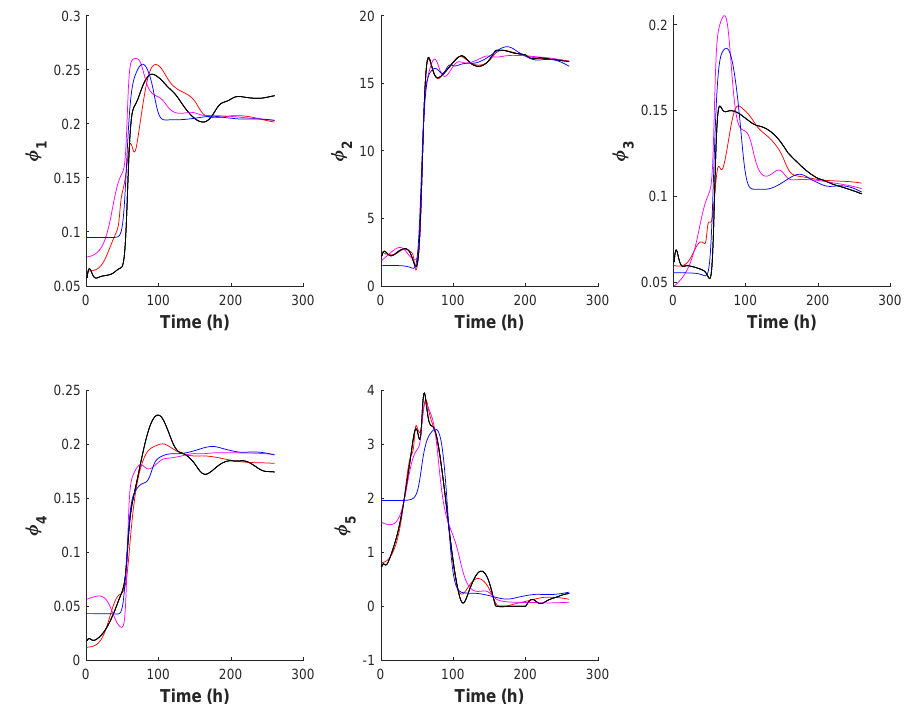
Figure 9. Time evolution of the specific reaction rates (in mM · h − 1 ) in dataset # 2—target values (black curves); prediction with an MLP with ten neurons (red curves), five neurons (magenta curves) and three neurons (blue curves) in the hidden layer.